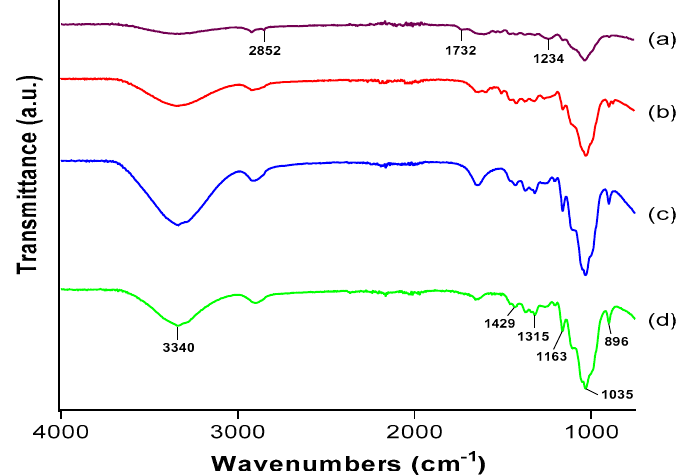
Figure 2. Fourier transform infrared (FTIR) spectra of (a) OPMF, (b) alkaline treated OPMF, (c) bleached OPMF and, (d) cellulose nanocrystals (CNC).